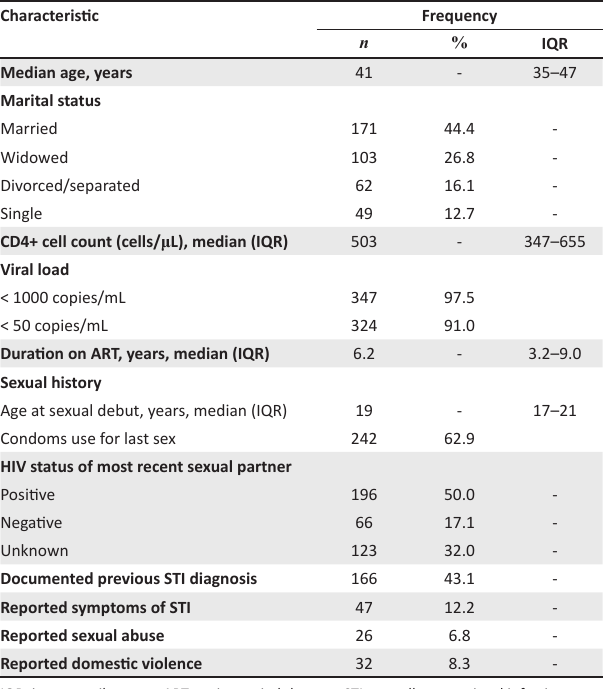
TABLE 1: Participant characteristics ( N =